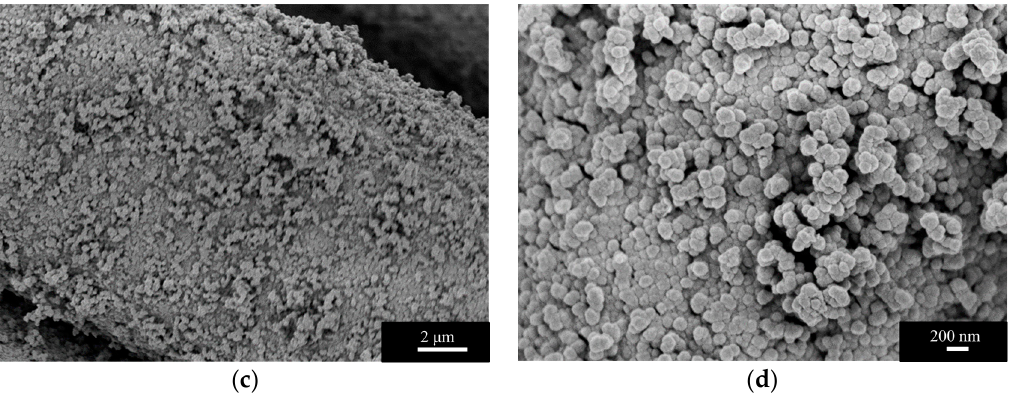
Figure 4. Scanning electron microscopy (SEM) images of ( a ) bare cotton fibers, and ( b – d ) cotton fibers functionalized with UiO-66 at different magnifications.